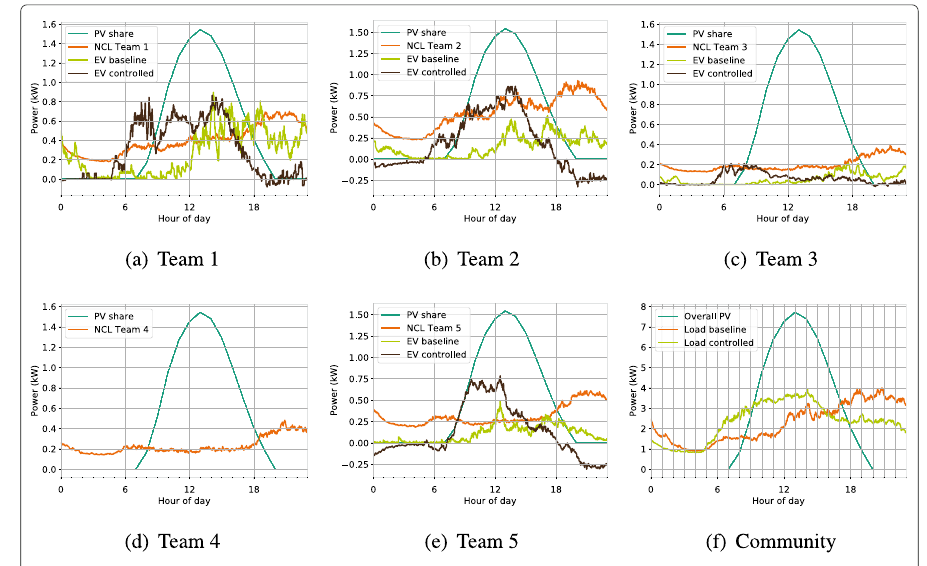
Fig. 3 Mean day PV utilisation for the different teams and the overall